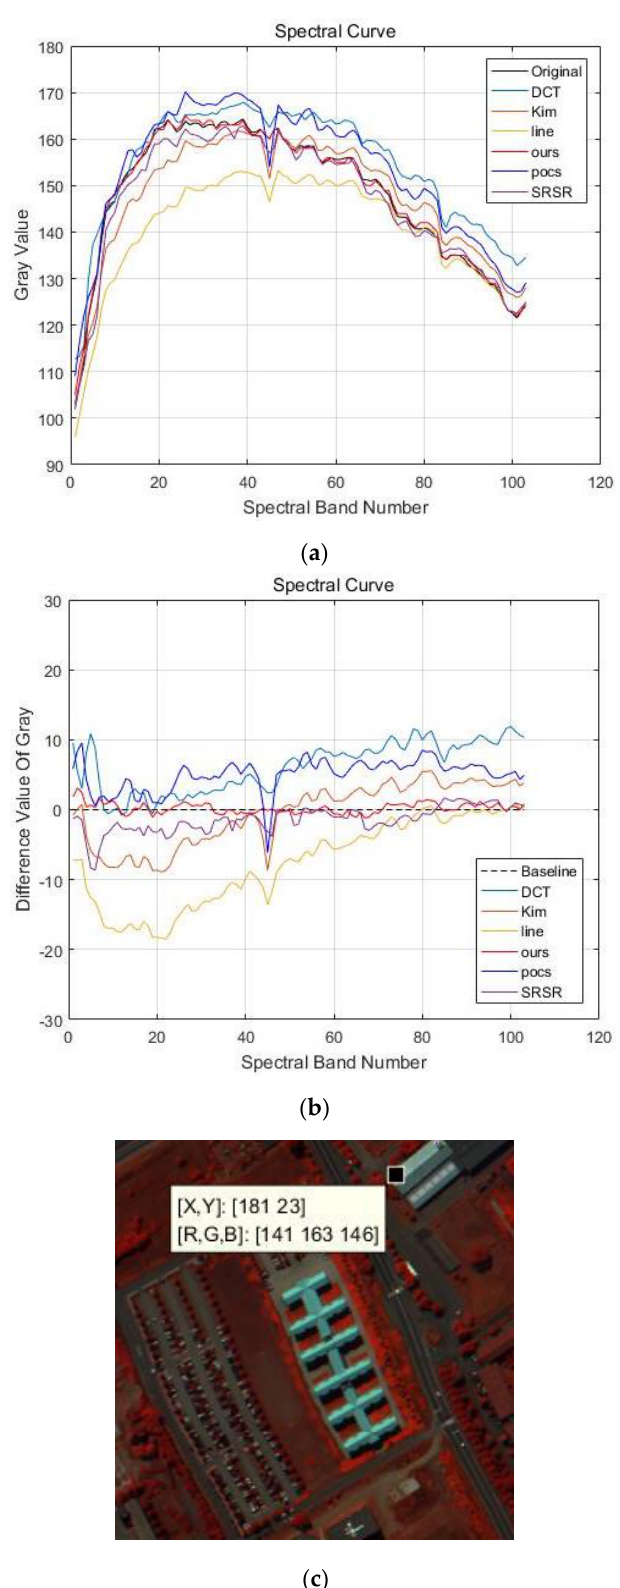
Figure 5. Spectral curves of pixel (181, 23) in the PaviaU dataset. ( a ) Spectral curves of different methods; ( b ) Difference values of spectral curves (the black dotted line is the baseline, the red line represents the results of the proposed methods); ( c ) spectral curve location.